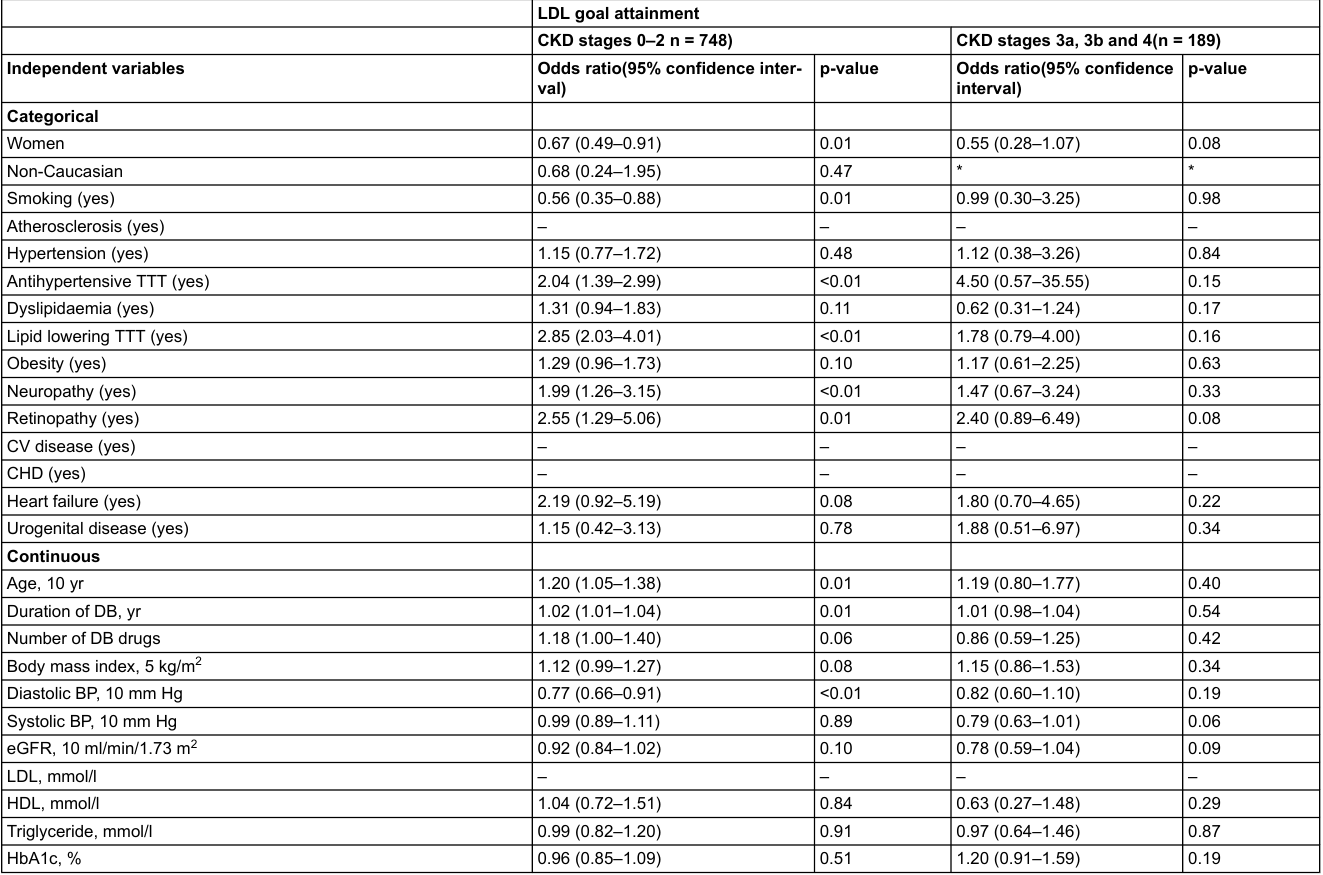
Table 5: Odd ratios for low-density lipoprotein goal attainment in univariate analysis (n =